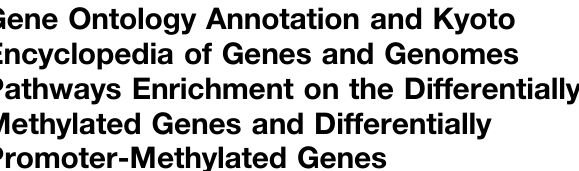
Frontiers in Genetics |